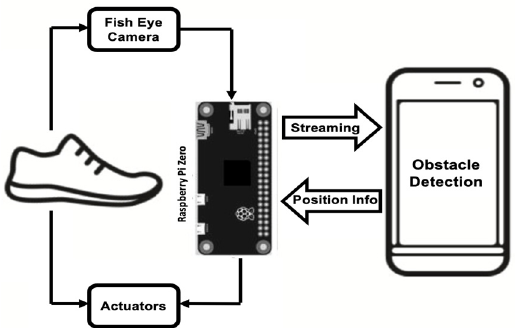
Figure 5. Block Diagram of the Smart shoe system with the fisheye camera. Adapted with permission from Ref [36]. Copyright 2021, IEEE